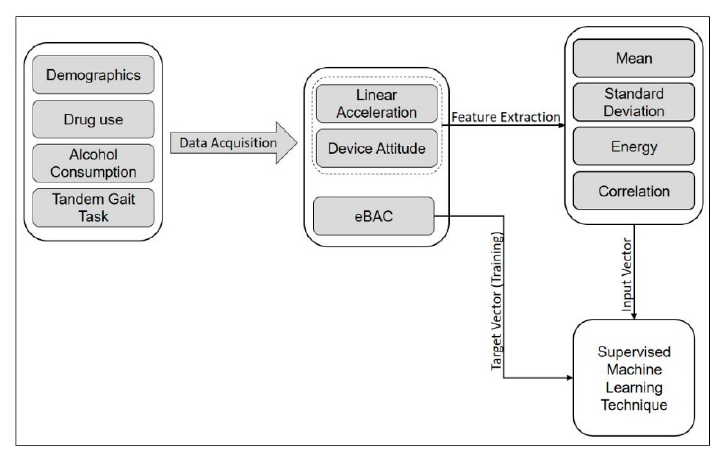
Figure 4. Schematic diagram of the data flow for eBAC estimation.